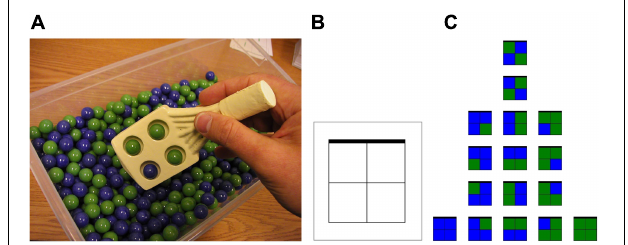
FIGURE 1 | Selected materials from a design for the binomial: (A) an open urn full of green and blue marbles with a scooper for drawing out four marbles; (B) a card for indicating possible outcomes using green and blue crayons (the thick line indicates “this side up” so as to distinguish rotations); and (C) the sample space of all possible experimental outcomes, made up of 16 such